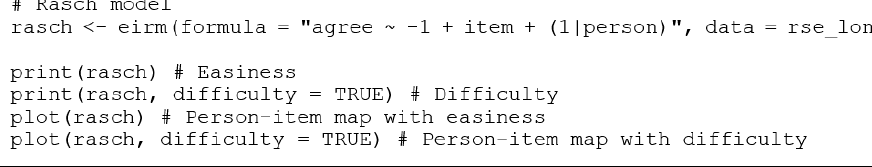
Figure 4. Estimate the Rasch model and print the model output.